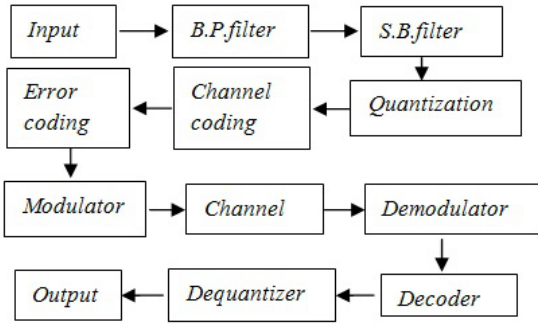
Fig. 9: Block diagram of the simulated